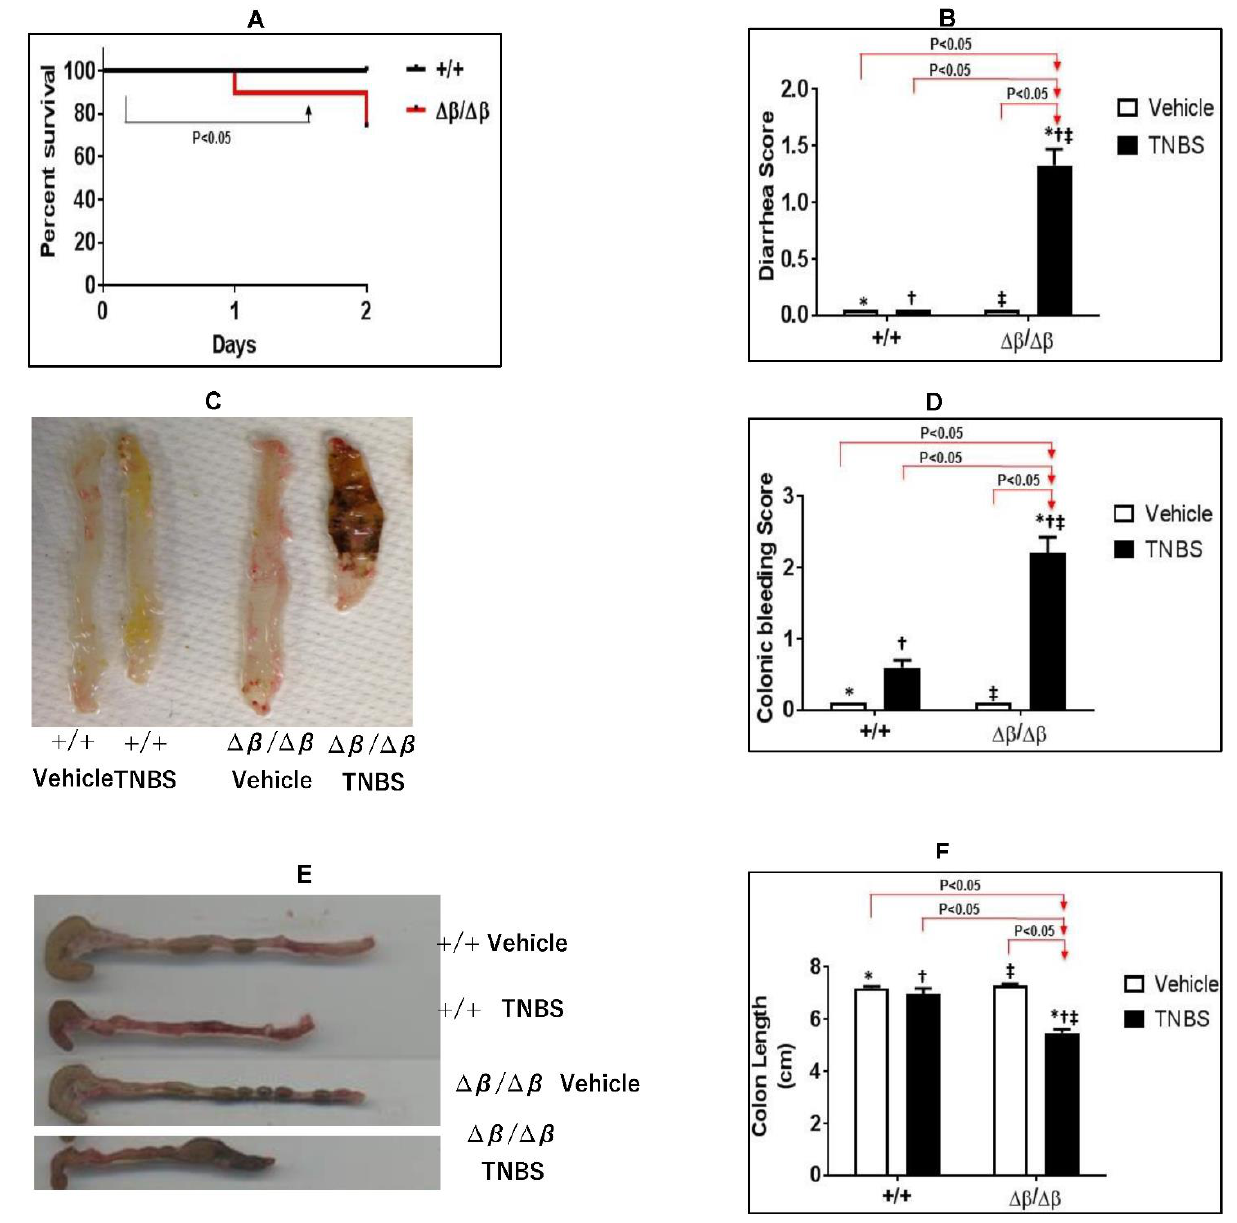
Figure 1. Ef fects of TNBS-induced CD on mortality, diarrhea, colonic bleeding, and colon shortening in +/+ versus ∆ β / ∆ β mice . Effect of STAT3 deletion on TNBS-induced CD was studied in +/+ and ∆ β / ∆ β mice. ( A ) Survival was assessed daily and was 74% in the TNBS ∆ β / ∆ β mice group vs. 100% in the TNBS +/+ mice group 48 hrs. post-administration of TNBS ( p < 0.05, Kaplan – Meier analysis, n = 9 – 19). ( B ) Diarrheal score, ( C , D ) colonic bleeding, ( E , F ), and colon length were assessed 48 hrs. post-administration of TNBS. Results are expressed as the mean ± SEM of two separate experiments [*, vehicle (+/+ mice) vs. TNBS ( ∆ β ∆ β /mice)], [ † , TNBS (+/+ mice) vs. TNBS ( ∆ β ∆ β /mice)], and [ ‡ , vehicle ( ∆ β /mice) vs. TNBS ( ∆ β ∆ β /mice)]; all p < 0 .05, ANOVA followed by Tukey’s post -test; n = 6 – 12.